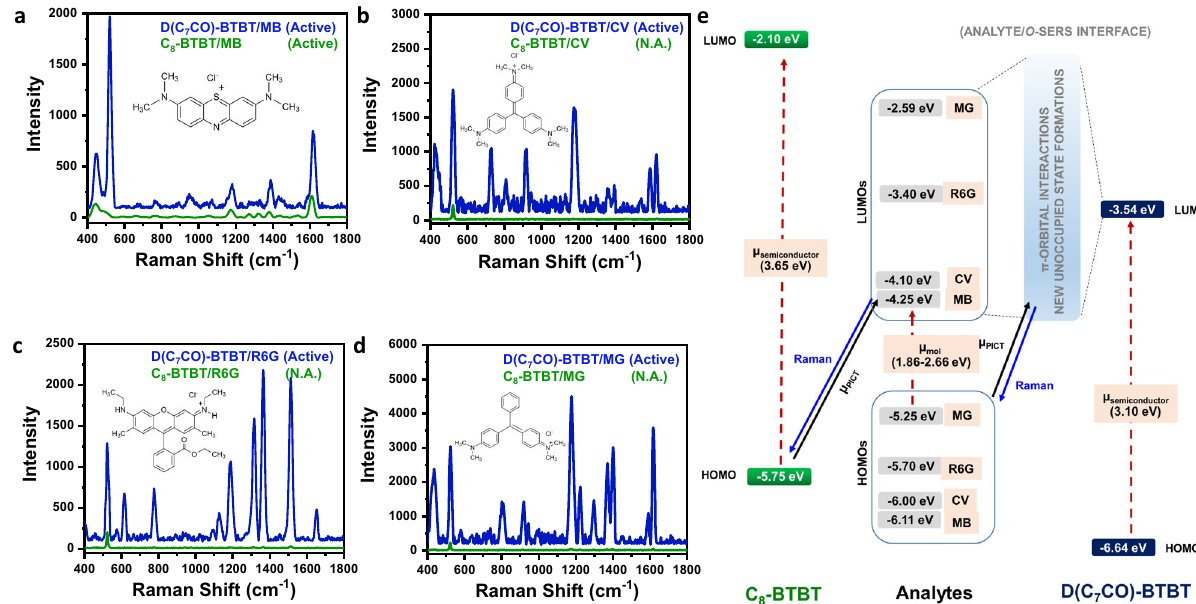
Fig. 6 Raman enhancement for D(C 7 CO)-BTBT and C 8 -BTBT fi lms, and chemical enhancement mechanism. SERS spectra of methylene blue (MB) ( a ), crystal violet (CV) ( b ), rhodamine 6 G (R6G) ( c ), and malachite green (MG) ( d ) analytes on D(C 7 CO)-BTBT and C 8 -BTBT fi lms. Insets depict the molecular structures of the analyte molecules. e Energy level diagram for the current analyte/ o -SERS systems for D(C 7 CO)-BTBT and C 8 -BTBT showing the frontier molecular orbital (HOMO/LUMO) energies and plausible (shown with solid black arrow)/non-plausible (shown with dashed red arrows) transitions. µ PICT stands for photoinduced charge-transfer between analyte and semiconductor under the excitation of 785 nm. Raman signals were produced during the transitions shown with blue solid